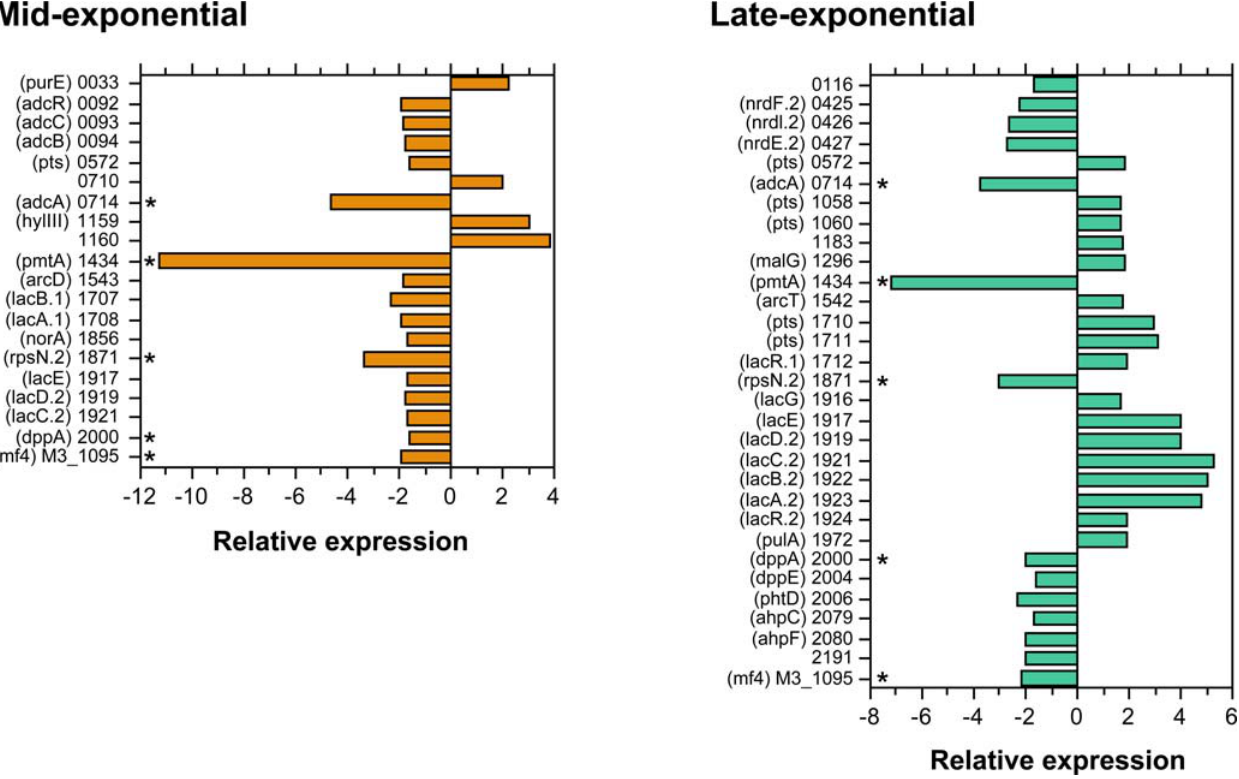
Figure 6. Genes controlled by PerR in GAS strain 003Sm during growth in mid-exponential (A 600nm =0.25) or late-exponential (A 600nm =0.60) phase growth. Values represent relative expression levels (fold-change) in wild-type bacteria compared to those in the perR mutant strain 003Sm perR D . Numbers on y -axis indicate SPy or spyM3 ORF numbers corresponding to M-type 1 strain SF370 [32] and M-type 3 GAS strain MGAS315 [18], respectively. *Genes regulated in similar fashion at both growth phases.